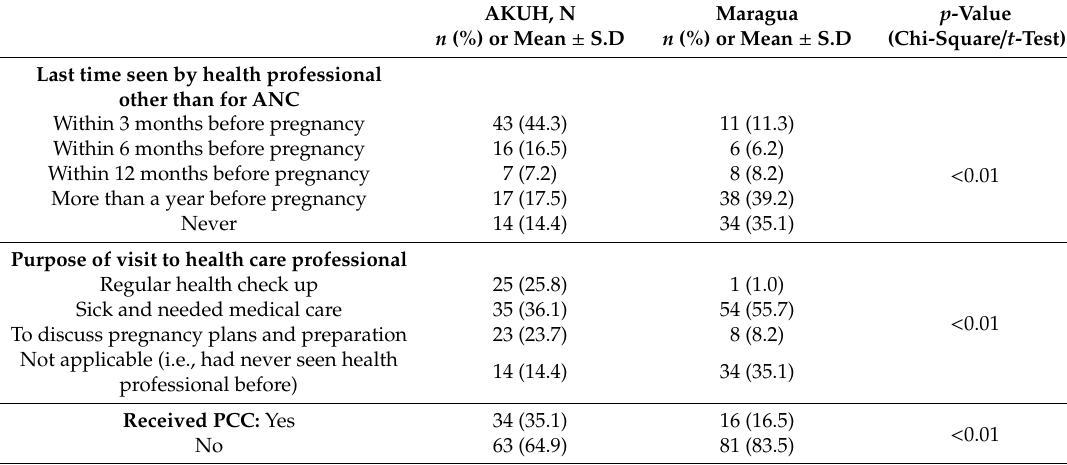
Table 2. Table of health-seeking behaviour by